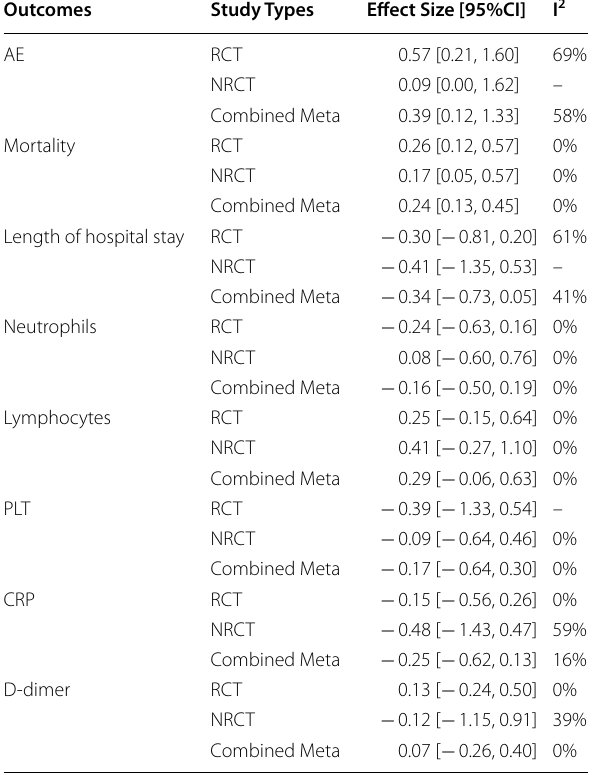
Subgroup analyses for AEs, mortality, length of hospital stay, neutrophils, lymphocytes, platelets, CRP and D-dimer according to type of study